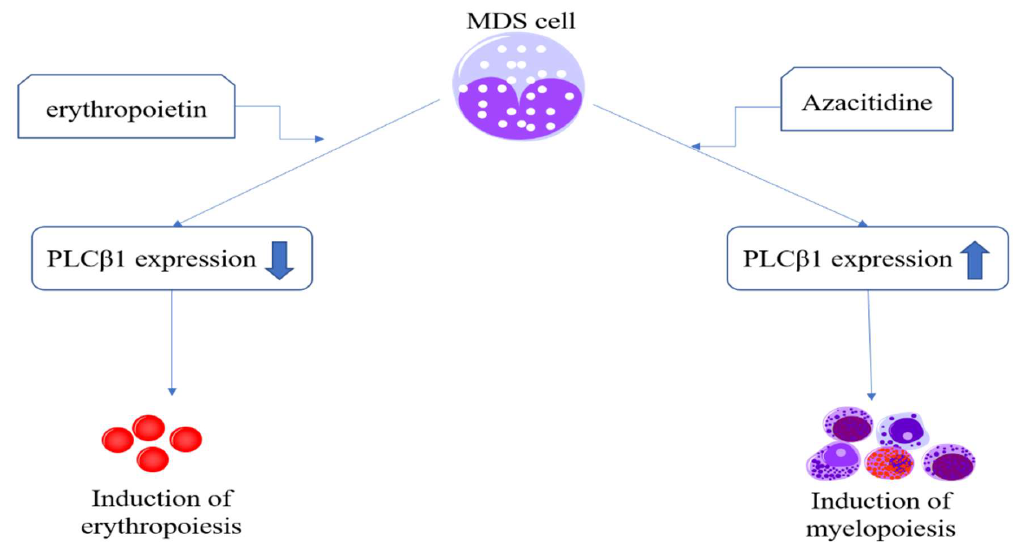
Figure 3. Nuclear PLCβ1 expression is critically associated with myelopoiesis and erythropoiesis of myelodysplastic syndromes (MDS) cells. Induced by demethylating agents, such as azacitidine, nuclear PLCβ1 shows a higher expression to promote myelopoiesis of MDS cells. On the contrary, when treated with erythropoietin, MDS cells downregulate nuclear PLCβ1 expression.